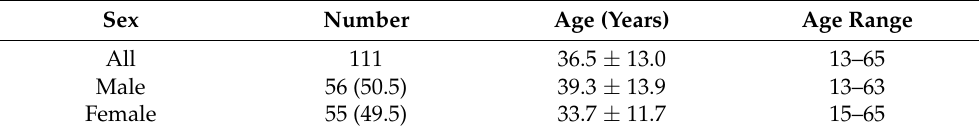
Table 2. Distribution of donor and recipient teeth.